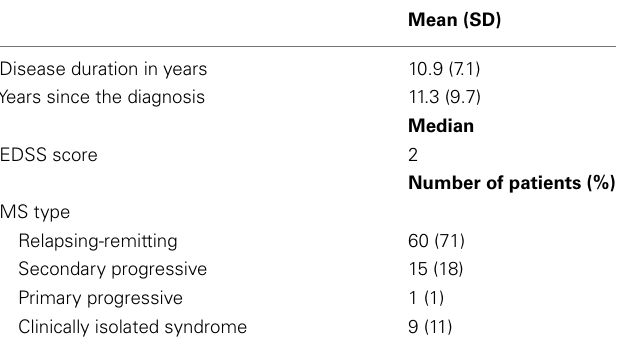
Table 2 | Clinical characteristics of the MS patient sample.